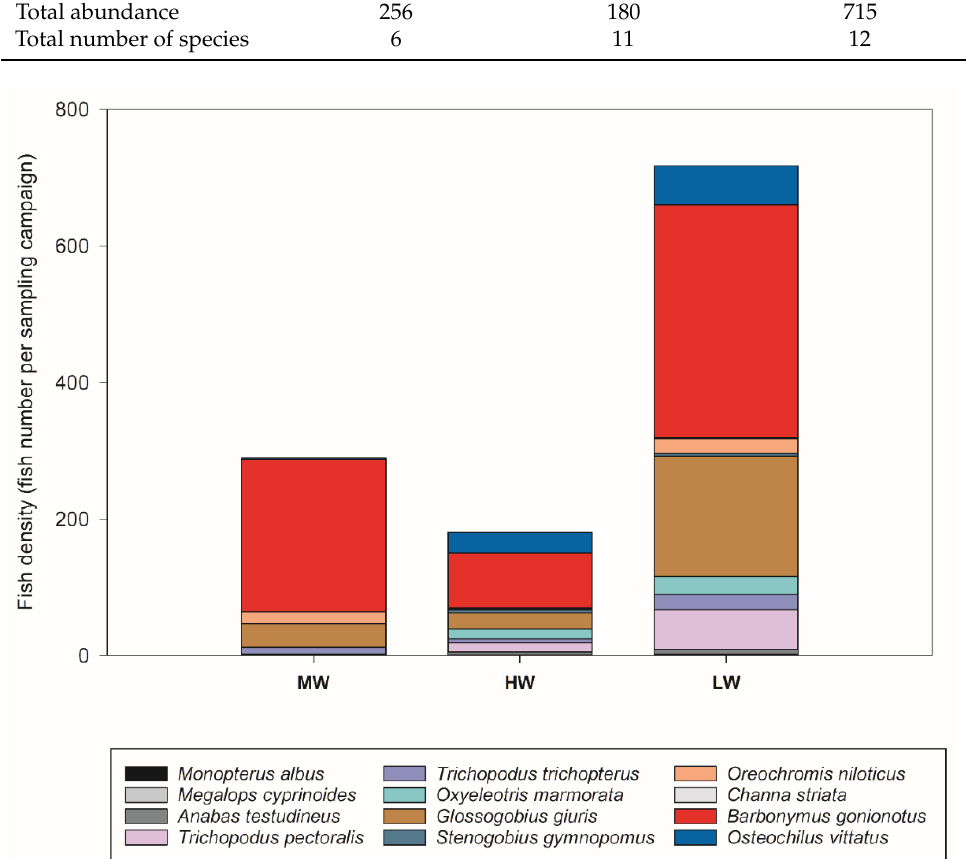
Figure 5. Fish density and species composition across three different hydrological periods: during the initial flooding season, when the water level was considered moderate (MW); during the flooding season, when the water level was maximum (HW); and during the dry season, when the water level was at its lowest (LW).